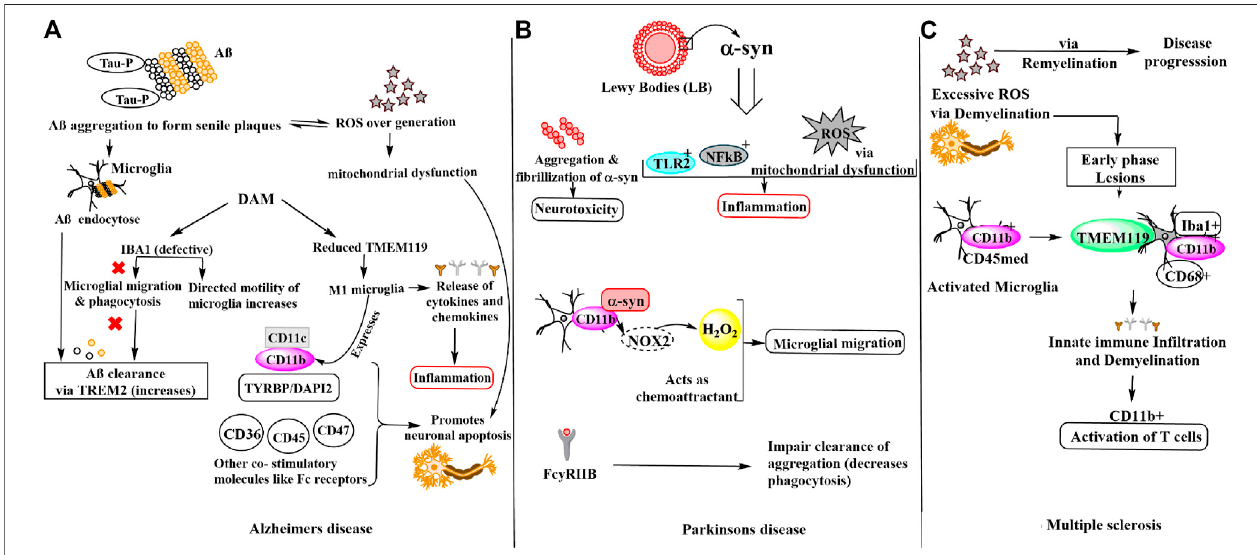
FIGURE 1 | Schematic representation of microglial involvement in disease pathogenesis of (A) Alzheimer ’ s disease (B) Parkinson ’ s disease (C) Multiple